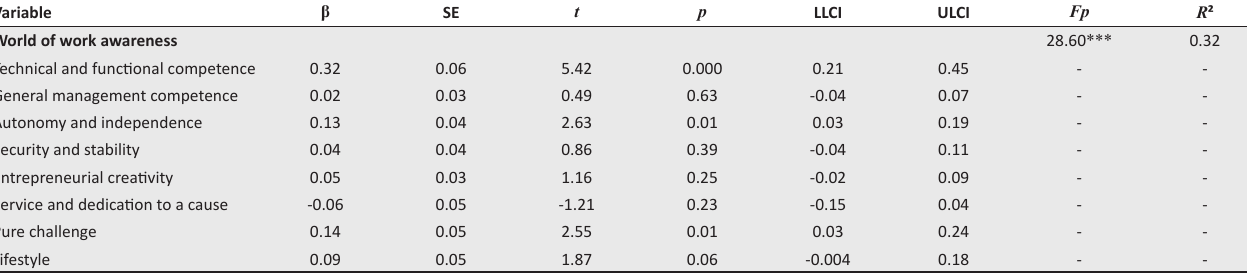
TABLE 2: Results of prediction effects on digital-era world of work awareness ( n = 486).